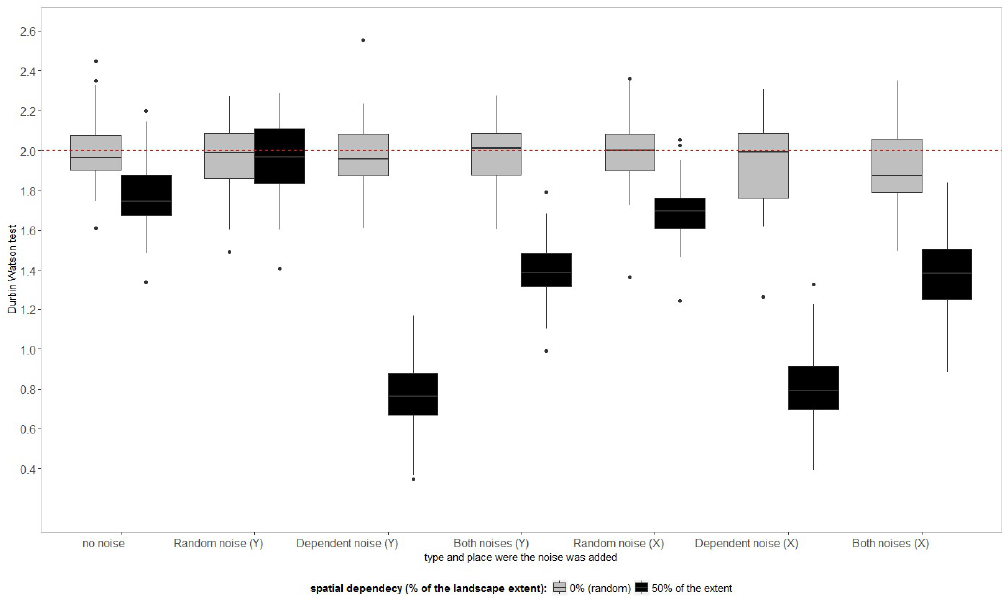
Figure A3. Results of Durbin Watson test for the residues of linear models for the landscapes without spatial dependency (grey) and with 50% of the extent (black). The red line shows the expected value for ideal random residues. The model residues were tested by adding random error, spatial dependent error and both noises into the response variable (LAI) or into the explanatory variable (spectra).